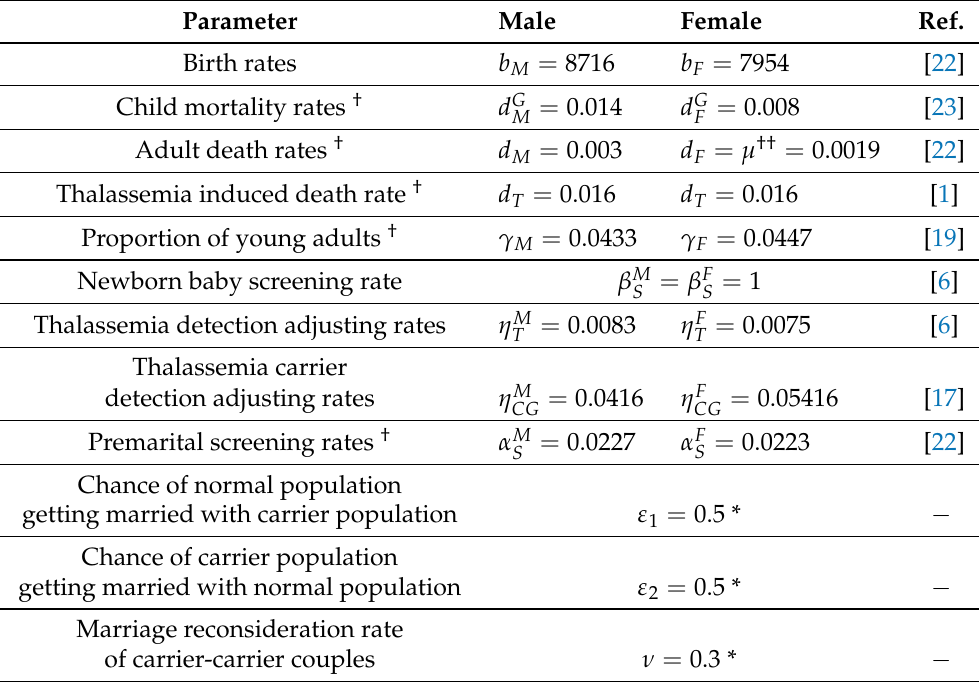
Table 1. Literature based and estimated parameter